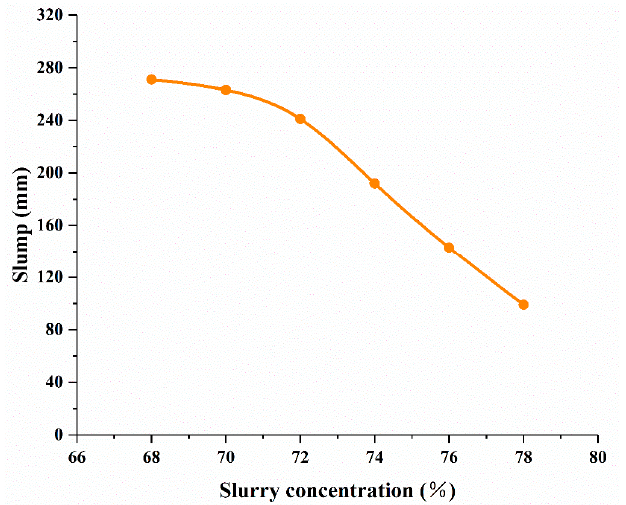
Figure 3. Variation of the slump of the cemented paste backfill (CPB) slurry with different Figure3. Variationof theslumpof thecementedpastebackfill (CPB)slurrywithdi ff concentrations.